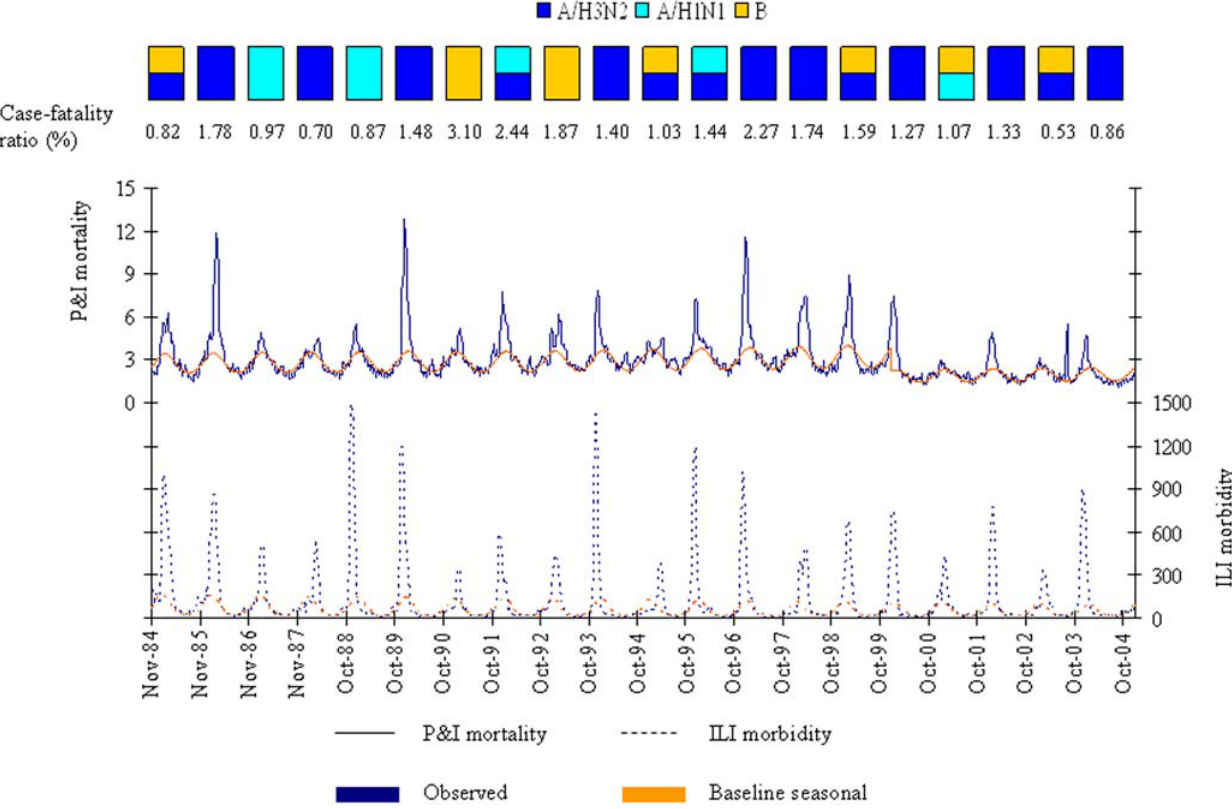
Figure 1. Observed and baseline seasonal rates of P&I mortality a and ILI morbidity b . The dominant types and subtypes of circulating influenza viruses in France, 1984–2004, are shown in the rectangles. The case-fatality ratio of influenza is defined as the ratio of cumulated excess mortality to cumulated excess morbidity in people over 65 years of age. P&I: pneumonia and influenza. ILI: influenza-like illness. a rates per week and per 100,000 inhabitants over 65 years of age. b rates per week and per 100,000